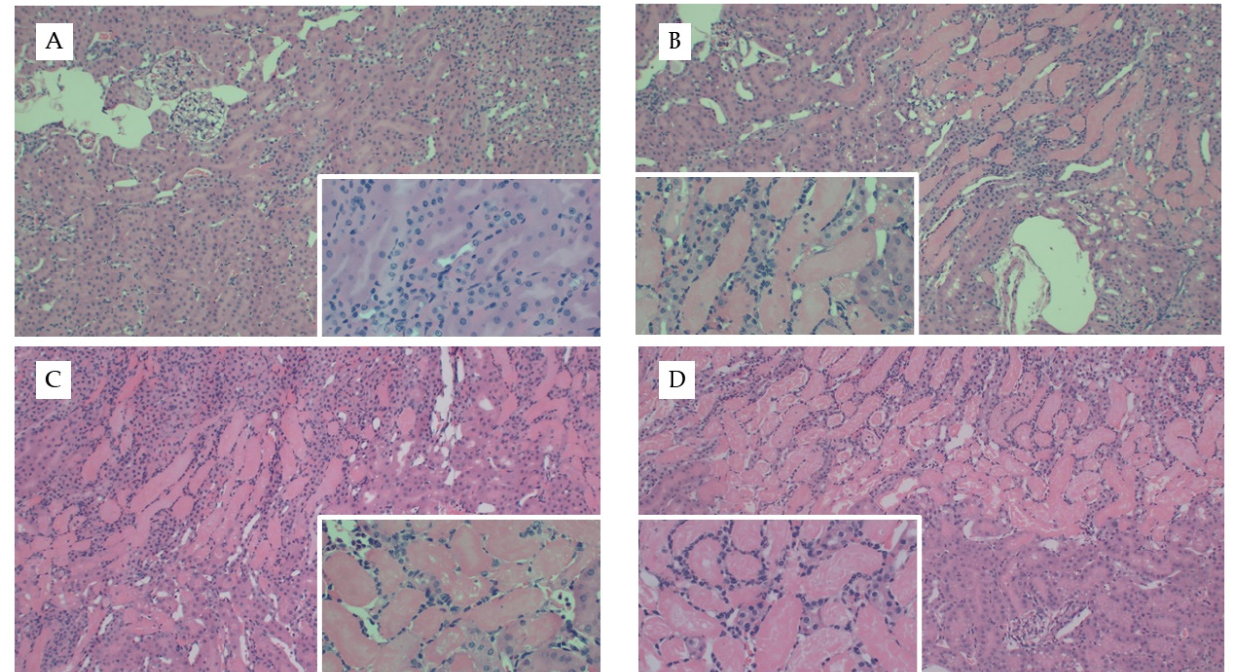
Nutrients 2021 , 13 , x FOR PEER REVIEW Figure 4. Representative kidney histology images from the uIRI study. Representative images from H&E stained kidney tissue from mice fed chow and ( A ) healthy control kidney, ( B ) uIRI, ( C ) mice fed WD and uIRI, or ( D ) mice fed AD and uIRI. Inset images show ( A ) normal renal tubular structure as compared to the ( B – D ) proteinaceous casts and acute tubular necrosis with uIRI. Larger images were captured with 10× and inset images were captured at 40×.